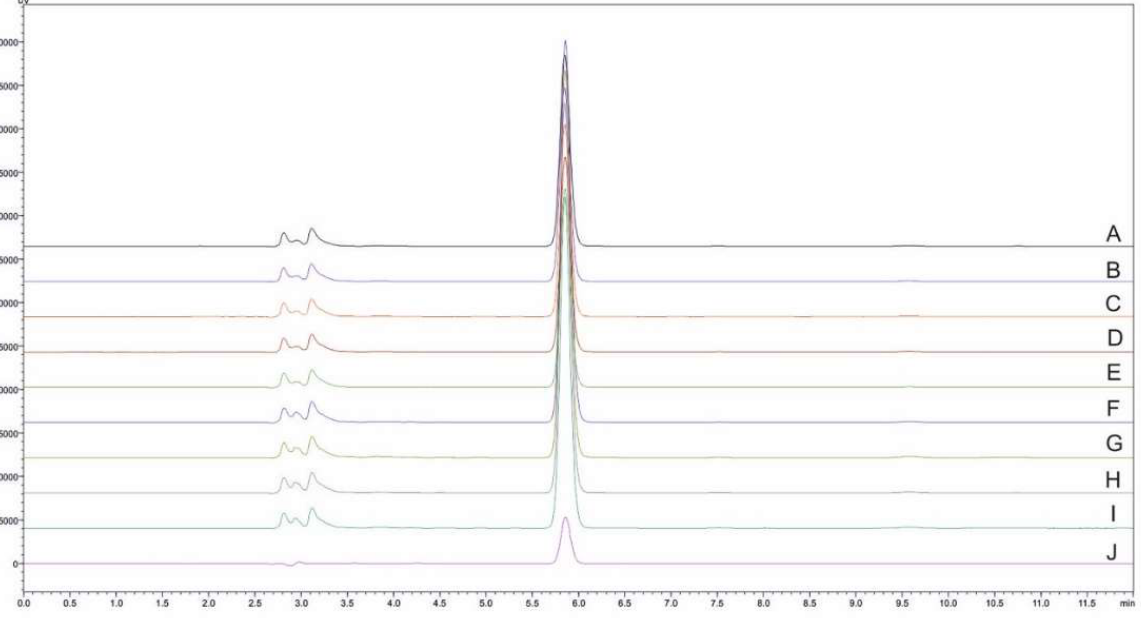
Figure 6. An overlay of chromatograms of the HPLC analysis of the dissolution samples taken at ( A – I ) 5–240 min, and ( J ) PAR standard solution (10% level). The bottom figure is a magnified over- laid chromatogram ( t R , PAR = 5.8 min). 3. Materials and Methods 3.1. Chemicals and Solutions The chemicals used in the present study were of at least analytical grade. Paracetamol (≥ 99%) was provided by Sigma-Aldrich (Steinheim, Germany). Acetonitrile, methanol (HPLC grade) and trifluoroacetic acid ( ≥ 99%) were obtained from Sigma-Aldrich (St Louis, MO, USA). The production of high-purity water was performed using a B30 puri- fication system (Adrona SIA, Riga, Latvia). Cellulose acetate membranes (0.45 μm, What- man ® ) were utilized for the aqueous mobile phase filtration. Pasteurized cow milk with low fat 0.1%, medium fat 1.5% and full fat 3.6% w/w con- tent (Declaration of Manufacturer) was purchased from local stores. These samples were stored at 4 °C until analysis.